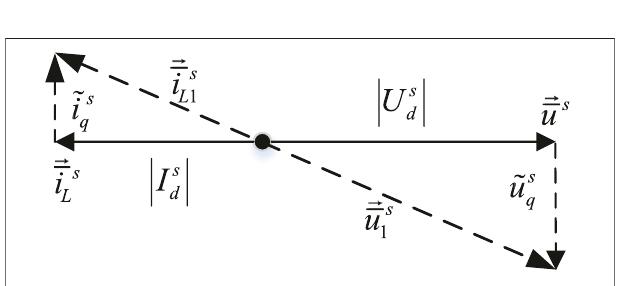
qq under different grid- connected